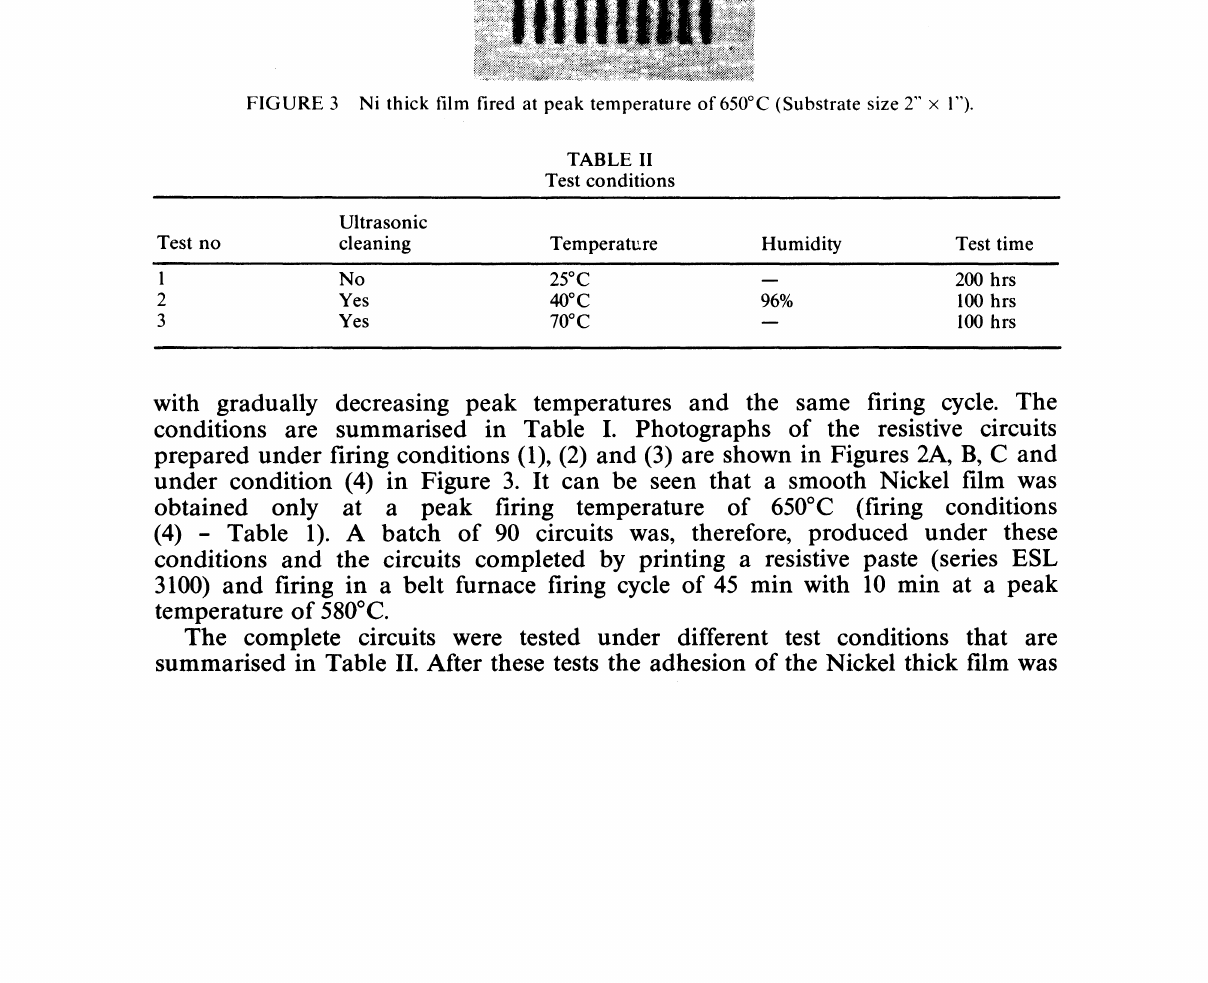
FIGURE 3 Ni thick film fired at peak temperature of 650C (Substrate size 2"